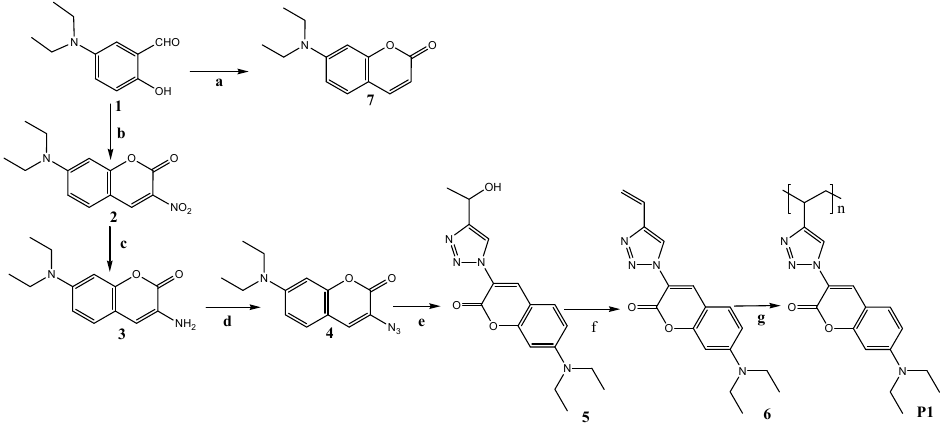
Table 1. Radical polymerization data and photophysical properties of polymer P1 .